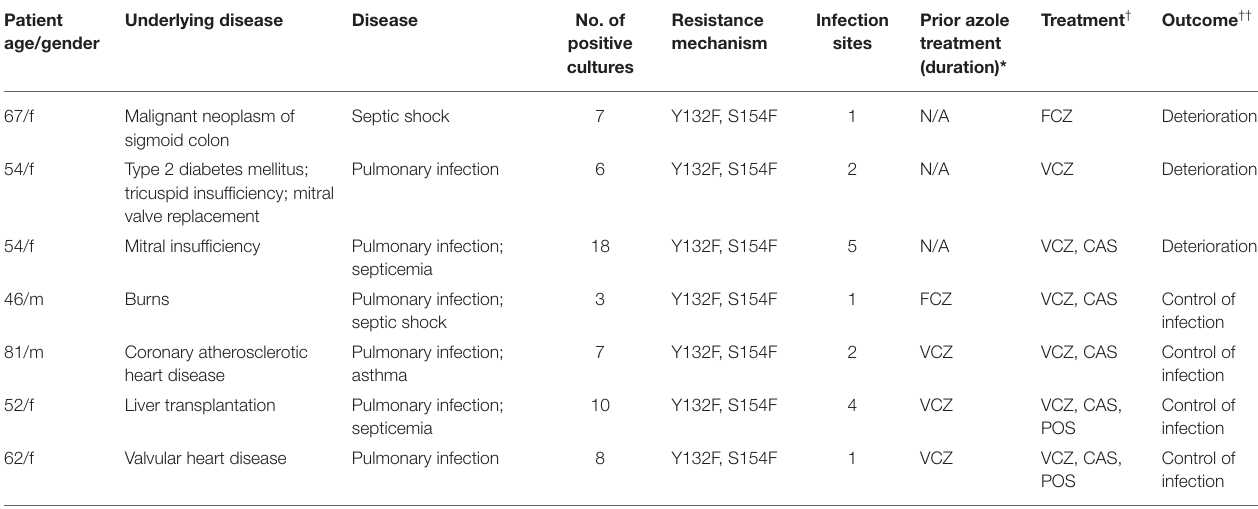
TABLE 3 | Characteristics of patients with azole-resistant C. tropicalis . Patient